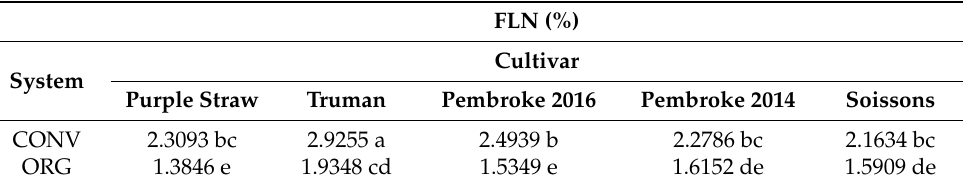
Table 4. Flag leaf nitrogen (FLN) content as affected by cultivar and production system at anthesis (first sampling date) in Y1 ( p = 0.0166). (Same letters within each column are not significantly different based on Tukey’s honest significant difference (HSD) test performed at α = 0.05).